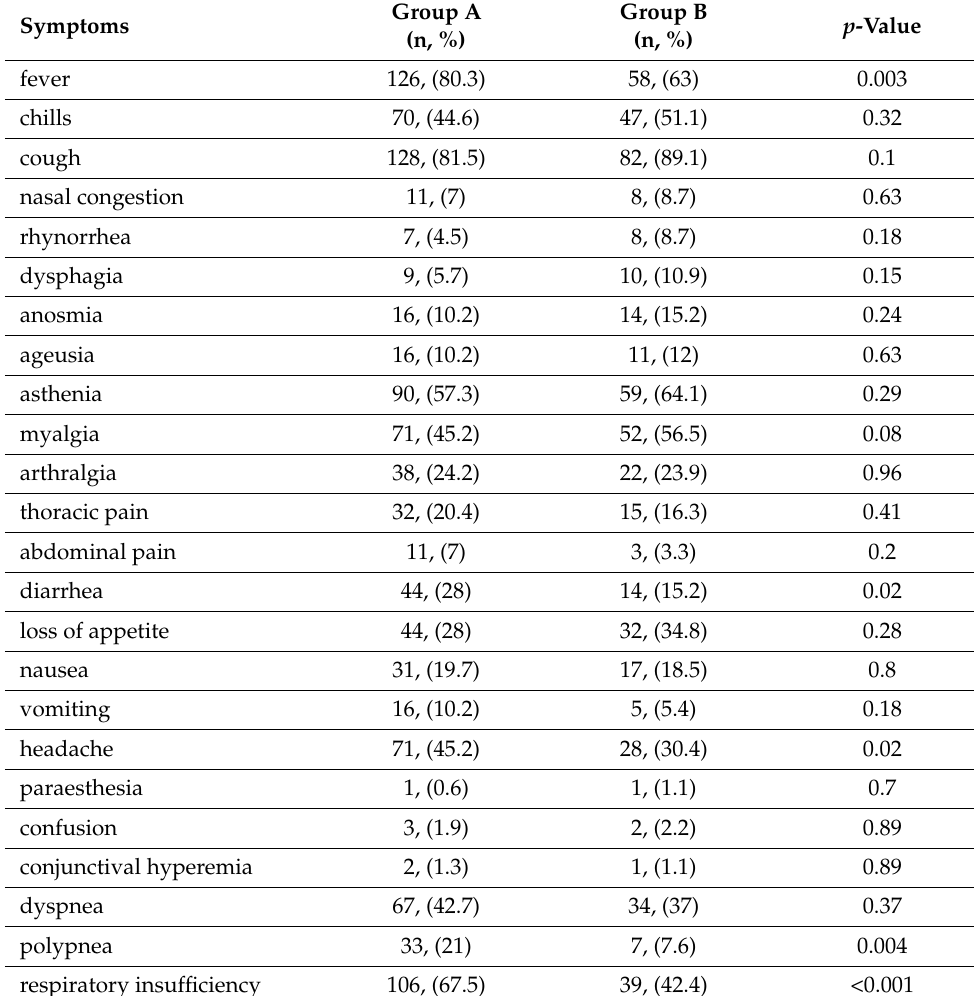
Table 4. Symptomatology of SARS-CoV-2 patients with and without liver